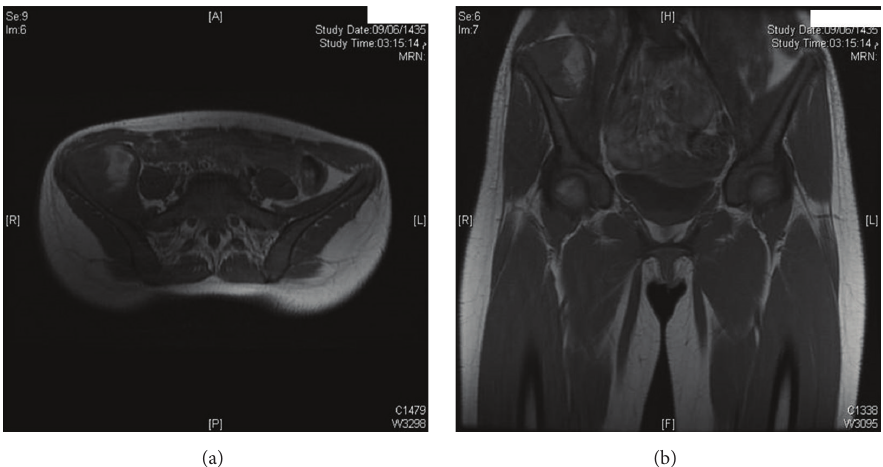
Figure 2: MRI images of the patient before initiation of neoadjuvant chemotherapy, showing mass arising along the right iliac bone, most probably soft tissue sarcoma with focal bony involvement.